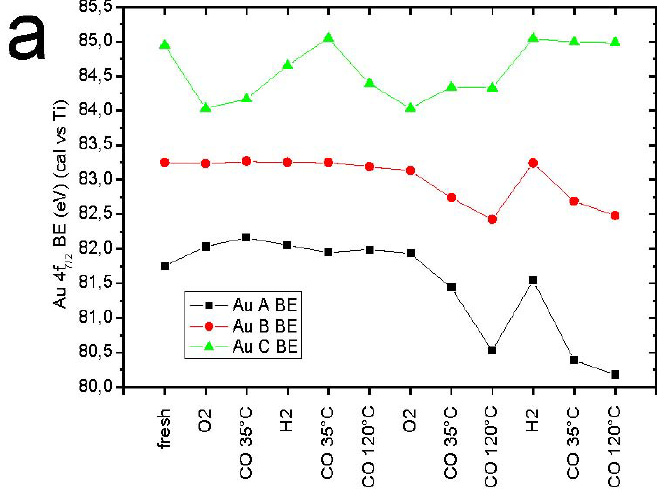
Figure 7. Au 4f component line behaviour. A: anionic gold (Au − δ C: cationic gold(Au + ) ( a ) Binding energy changes; ( b ) Contents of various Au